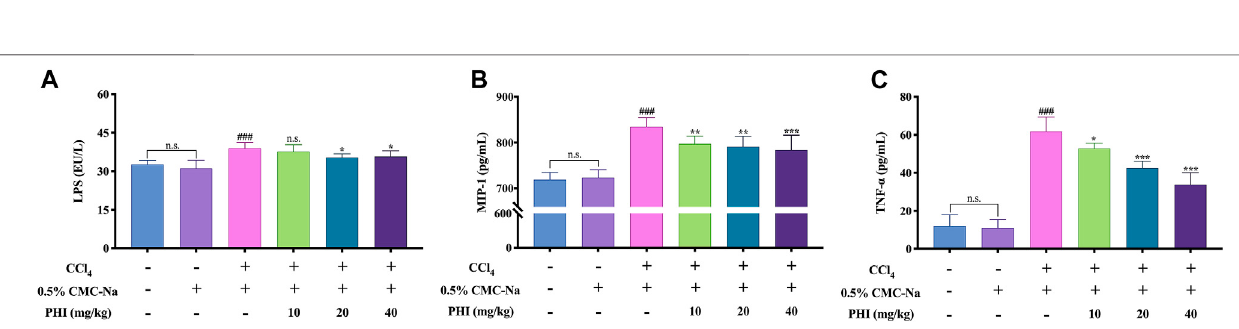
Frontiers in Pharmacology |